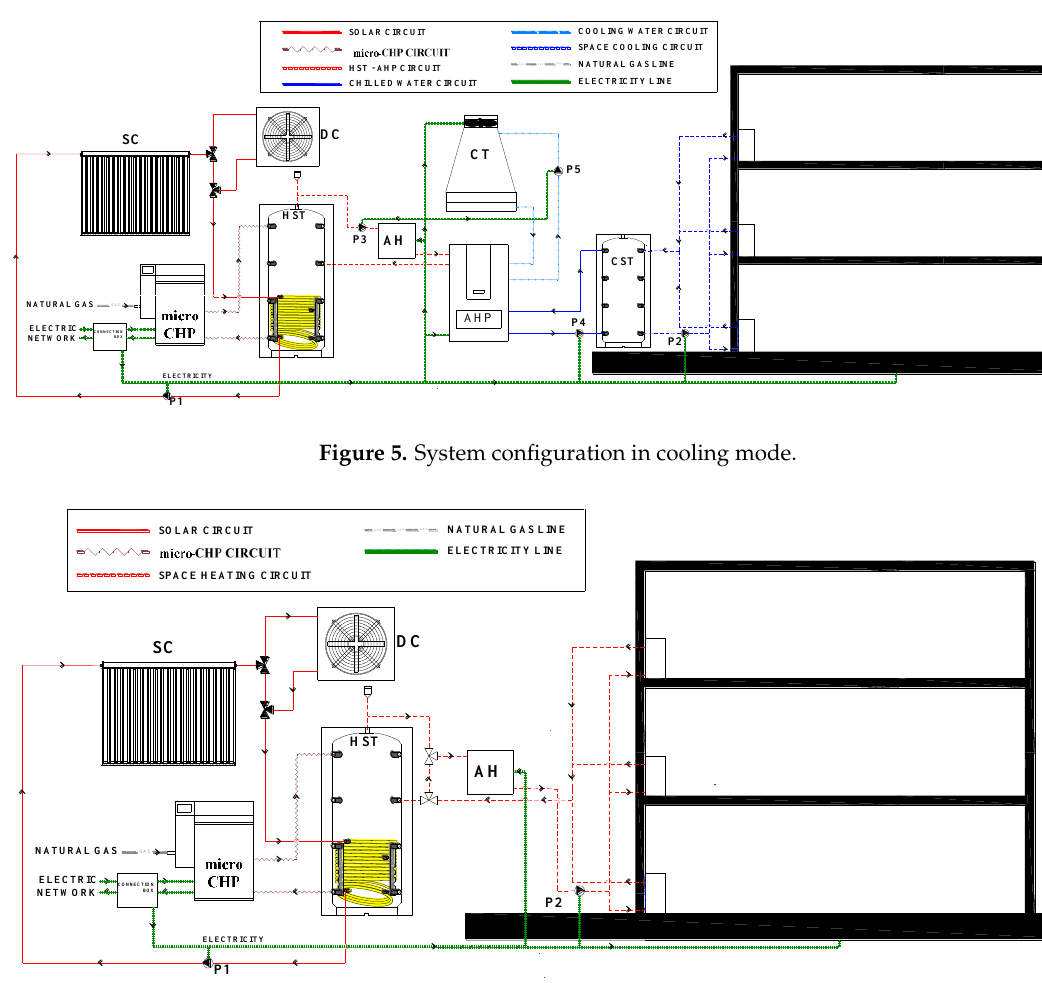
Figure 6. System configuration in heating mode.